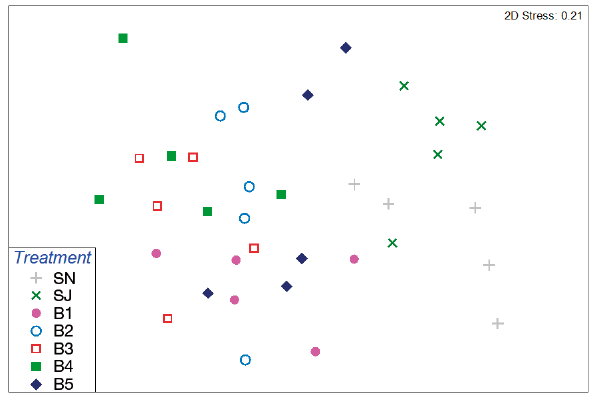
Fig. 6. Two-dimensional MDS plot of 35 holdfasts: 25 benthic samples (B1–B5, spatially separate locations in kelp bed) and 5 suspended samples (different droppers from longline) sown in November (SN) and 5 sown in January (SJ), based on presence− absence Simpson’s dissimilarity matrix of faunal species collected from each